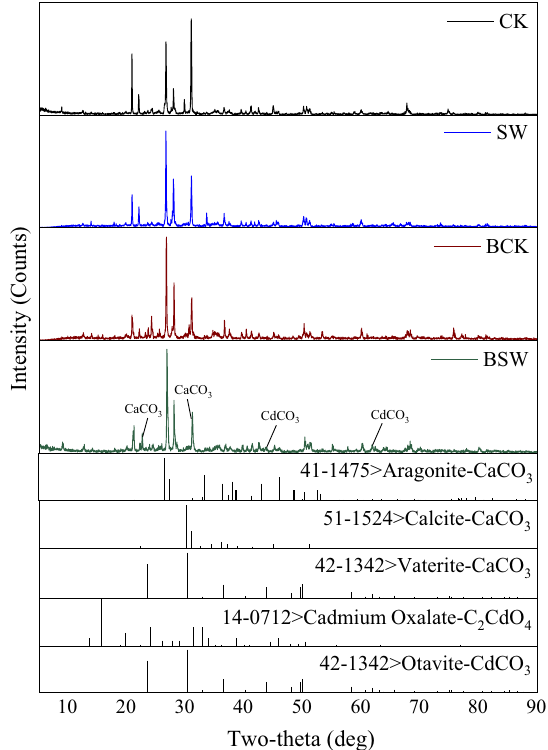
Fig. 2 XRD patterns of the soil samples. CK: control; SW: soil treated with 1%‑biochar; BCK: soil treated with S. pasteurii ; BSW: soil treated with S. pasteurii and